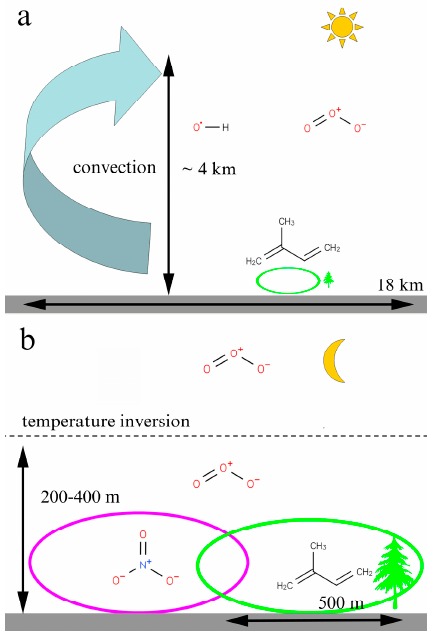
Figure 11. The simple diagram, showing the transition due to the deterioration of the atmospheric mixing, from the homogeneous chemical state in the daytime ( a ) to a heterogeneous state in the night-time ( b ). The ellipses show the chemical compounds, which cannot have been uniformly distributed on a model domain scale. In this study, the horizontal size of a domain cell is equal to 18 km. On the one hand, the O 3 and OH-radical are nearly homogeneously distributed in the troposphere [see ( a )]. The diagram explains the reason for the increase of chemical reaction noises at night.